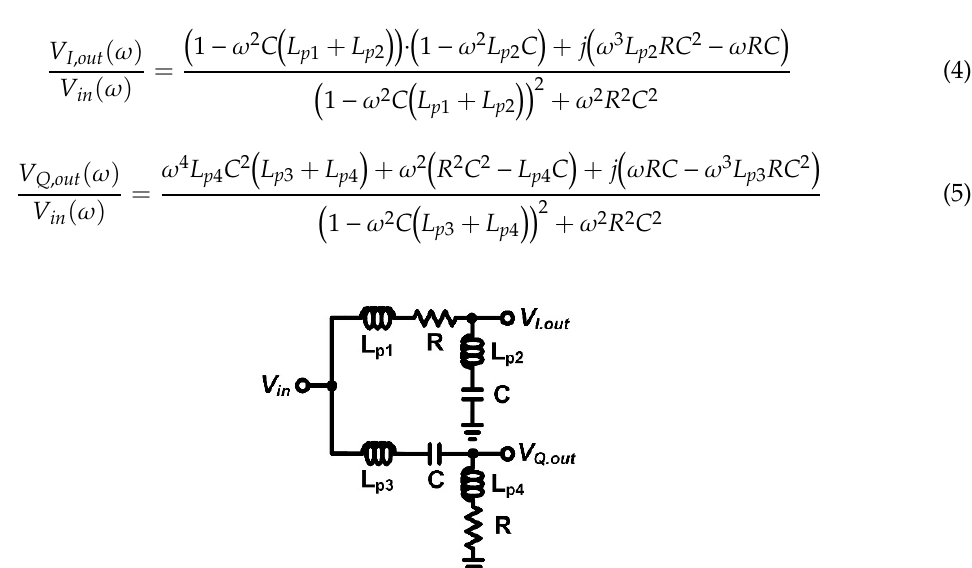
Figure 5. Simplified schematic of the proposed poly-phase filter-based I / Q LO generation circuits.